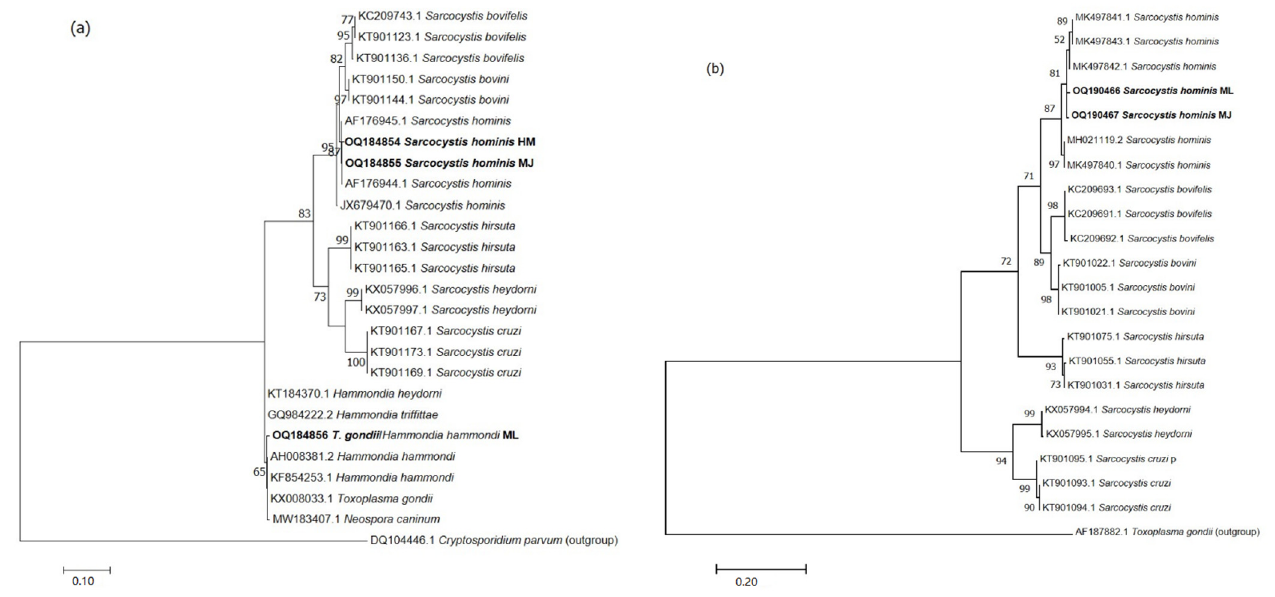
Figure 3. Maximum Likelihood trees inferred from Sarcocystis homins and Toxoplasma gondii 18S rDNA ( a ) and COI mtDNA ( b ) from this study and sequences retrieved from GenBank. The evolutionary history was computed with the Kimura 2 ‐ parameter model. The tree is drawn to scale, with branch lengths measured in the number of substitutions per site. There were a total of 207 position for 18S rDNA and 348 for COI mtDNA in the final data sets. Our specimens are in bold. HM = healthy muscle; ML = macroscopic lesion; MJ = meat juice pellet. Table 2. Results of PCR and Sequencing on tested samples.